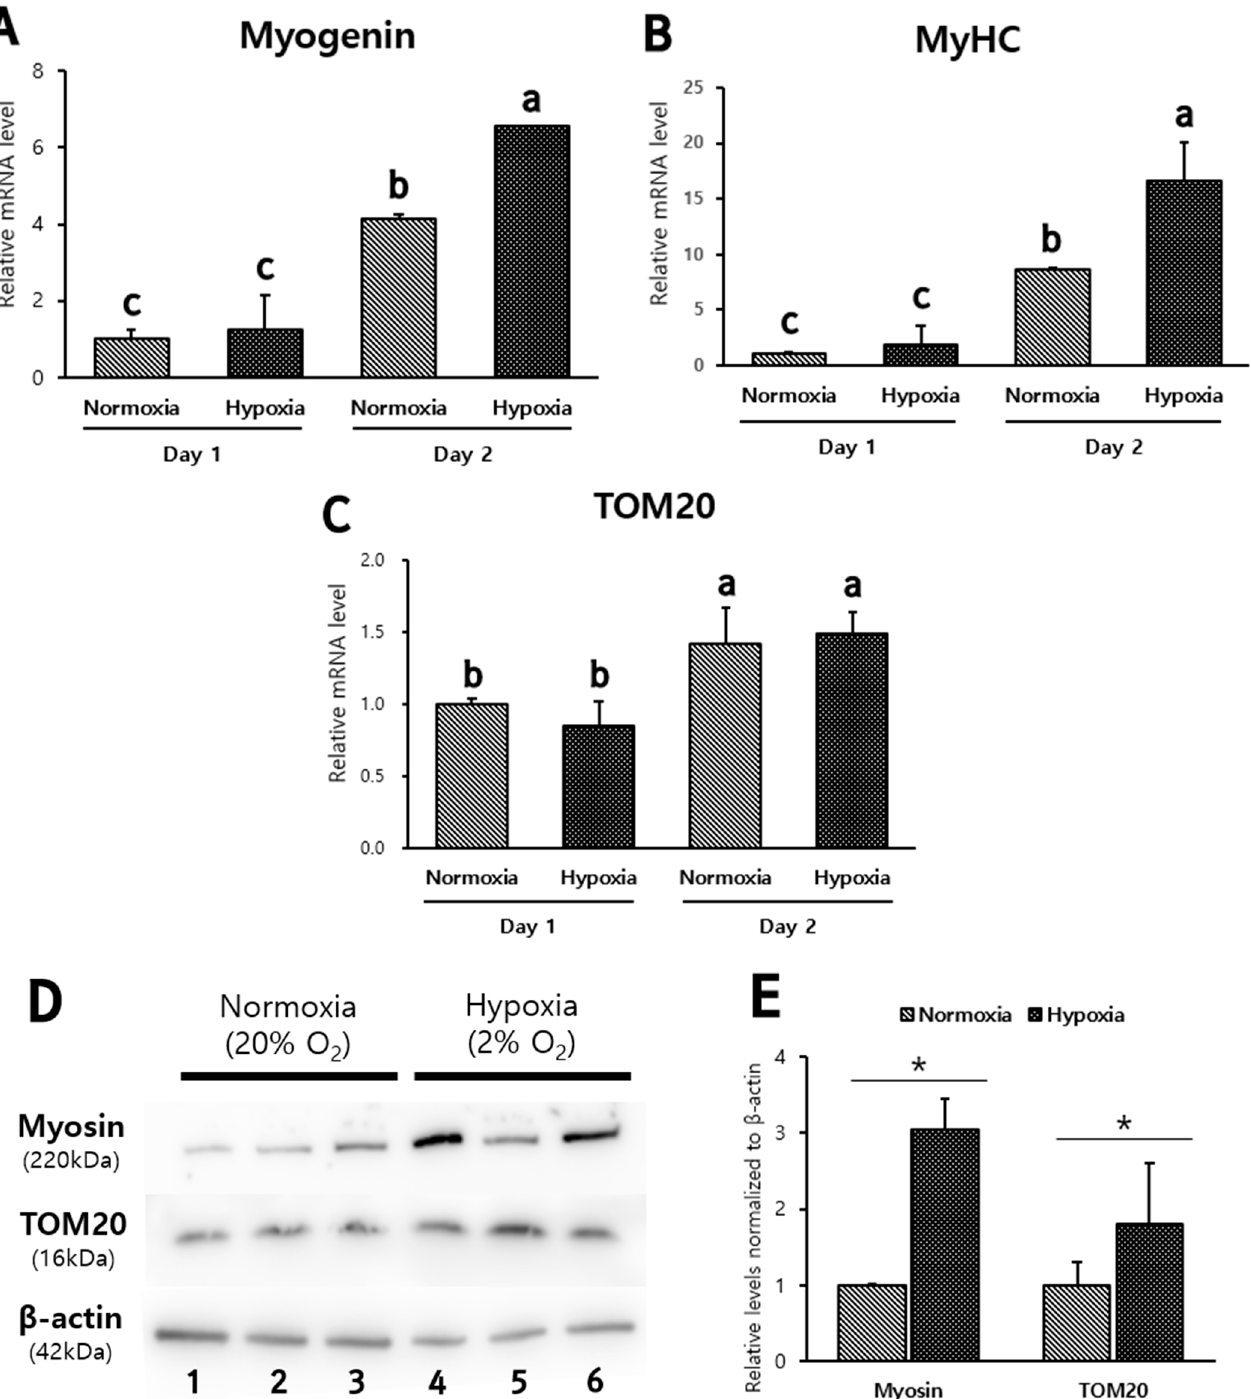
Figure 5. The confluent cells were cultured under hypoxia or normoxia for 1 and 2 days. Myogenin ( A ), MyHC ( B ) and TOM20 ( C ) mRNA levels were relatively analyzed. GAPDH was used as an internal control for RT-PCR. Experiments were performed in triplicate and repeated three times. Mean ± standard deviation with differing letters differ significantly ( p < 0.05). The confluent Hanwoo muscle cells were cultured for 2 days in DM. ( D ) is representative images of Western blotting against Myosin, TOM20 and β -actin from lysates of differentiated Hanwoo muscle in hypoxia (2% O 2 ) (Lane 1, 2, 3) and in normoxia (20% O 2 ) (Lane 4, 5, 6). ( E ) is relative levels of myosin and TOM20 normalized to β -actin from ( D ). Asterisk means significant difference (* p < 0.05) ( n =